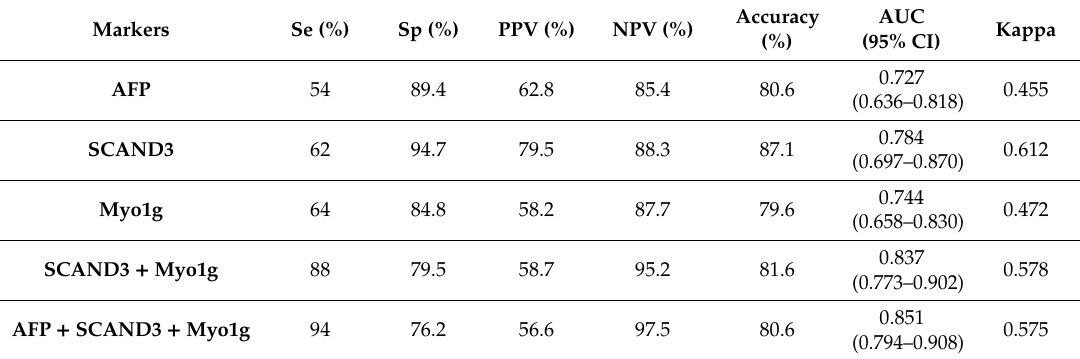
Table 2. Diagnostic values of serum gene methylation markers and AFP in predicting early-stage HCC.